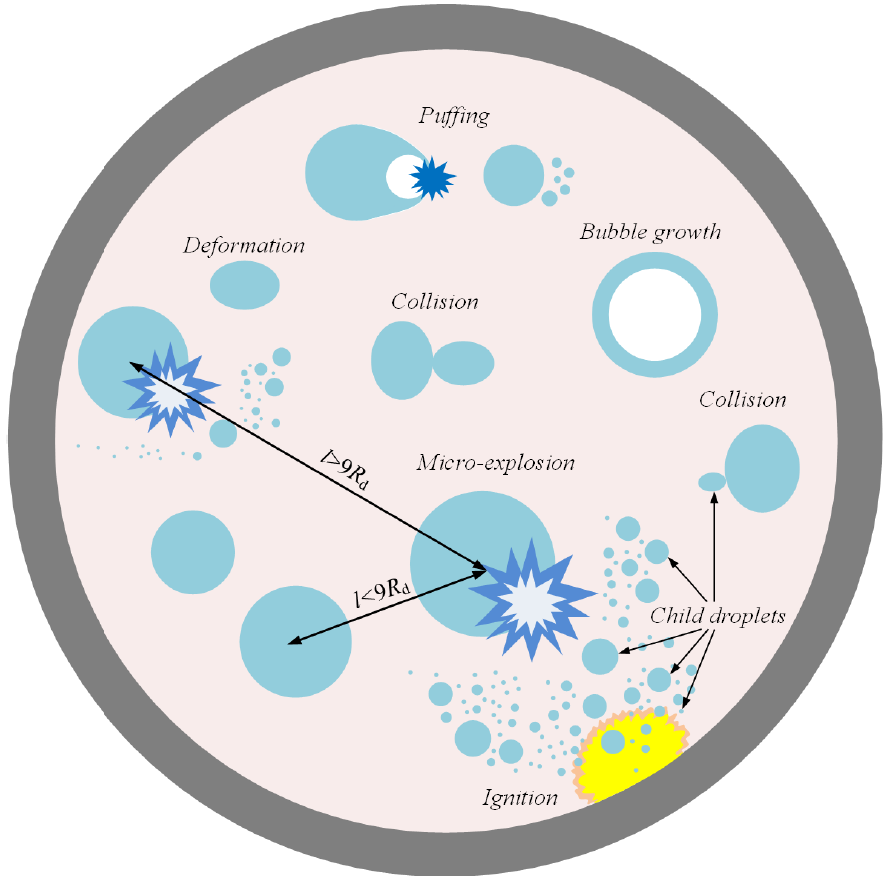
Figure 4. Joint effects of micro-explosive atomization of multi-component droplets in a model chamber based on the analysis of research findings [114]. Table 1. Known data on the characteristics of droplet micro-explosion for different liquids.